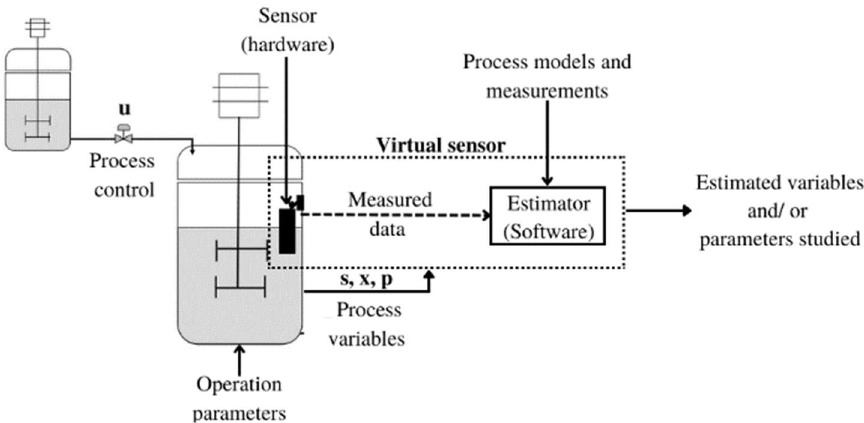
Figure 1. General scheme of the implementation of a virtual sensor in a